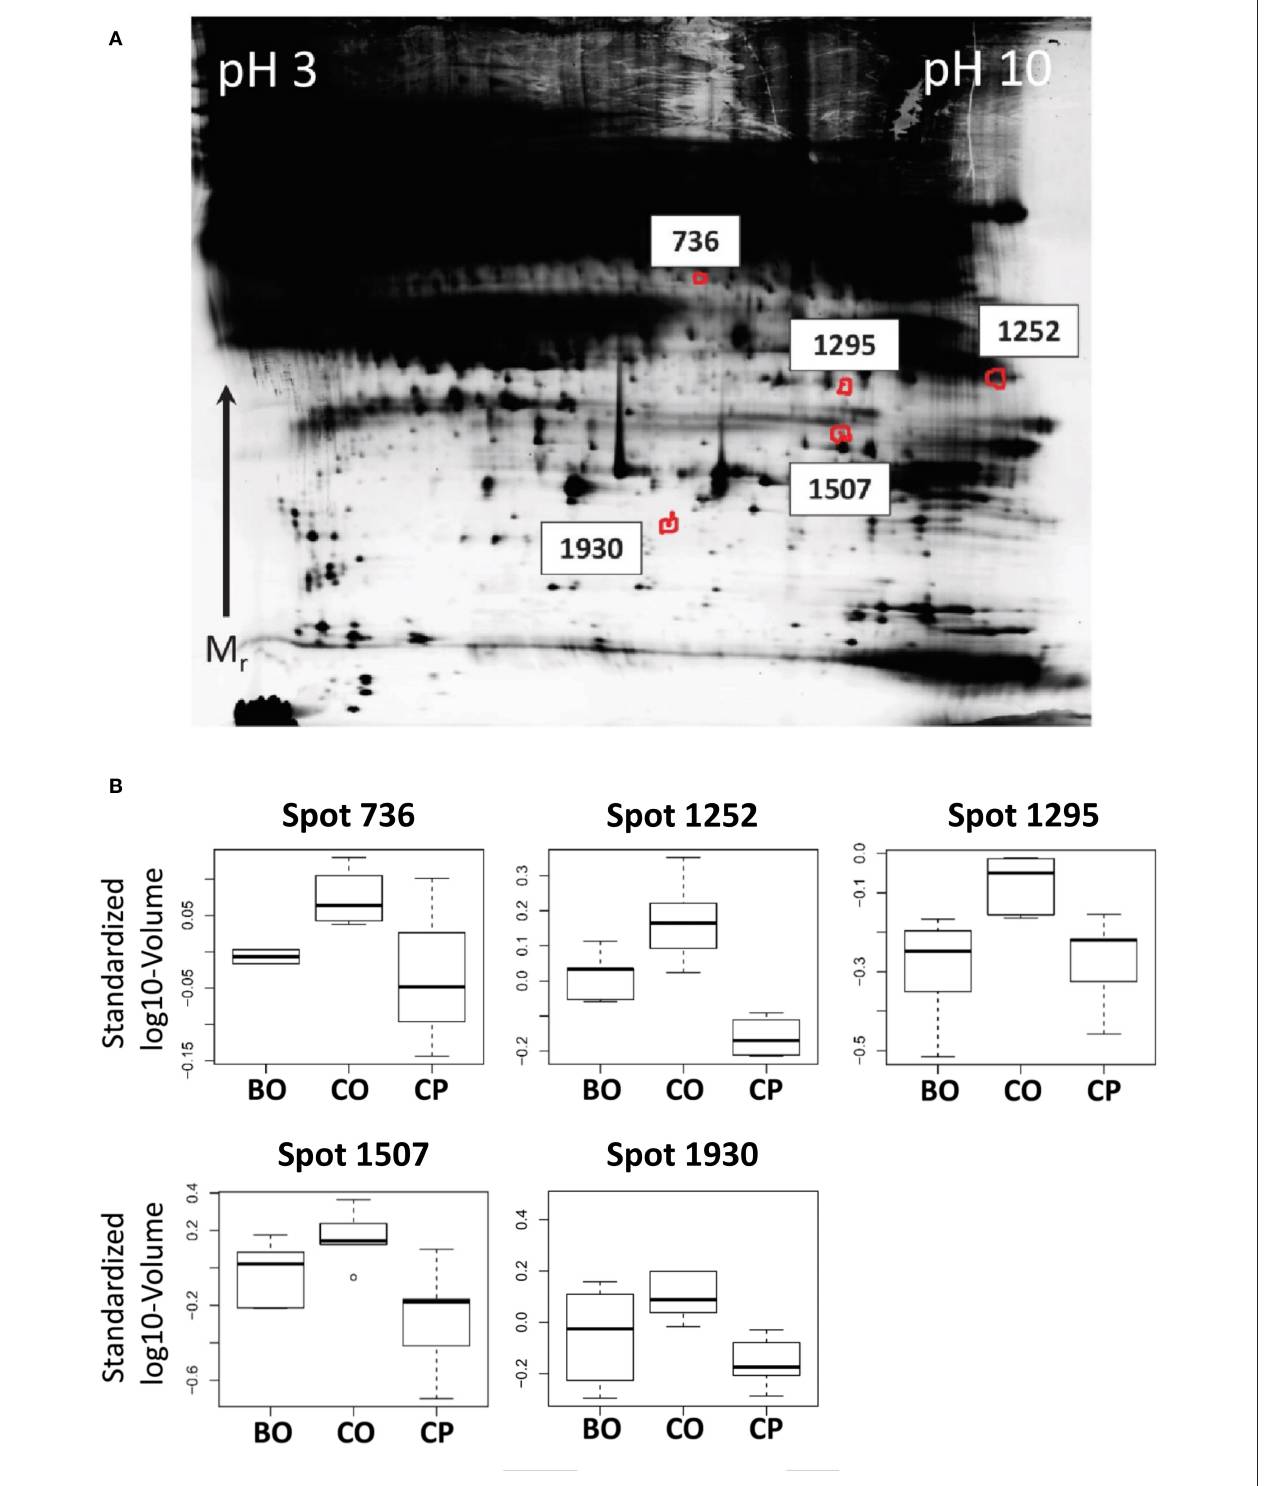
FIGURE 2 | (A) Representative, contrast-adjusted DIGE image of depleted serum. Numbers indicate spots higher abundant in ovarian vs. peripheral blood from early stage ovarian cancer patients and ovarian blood from patients with benign ovarian lesions. (B) Boxplots of spot abundance across the analyzed DIGE gels. Samples: CO, Cancer ovarian serum; CP, Cancer peripheral serum; and BO, Benign ovarian serum. All p -values between CO vs. CP and CO vs. BO < 0.05. JUP was identified in all spots by mass spectrometry (see Table S3 ).